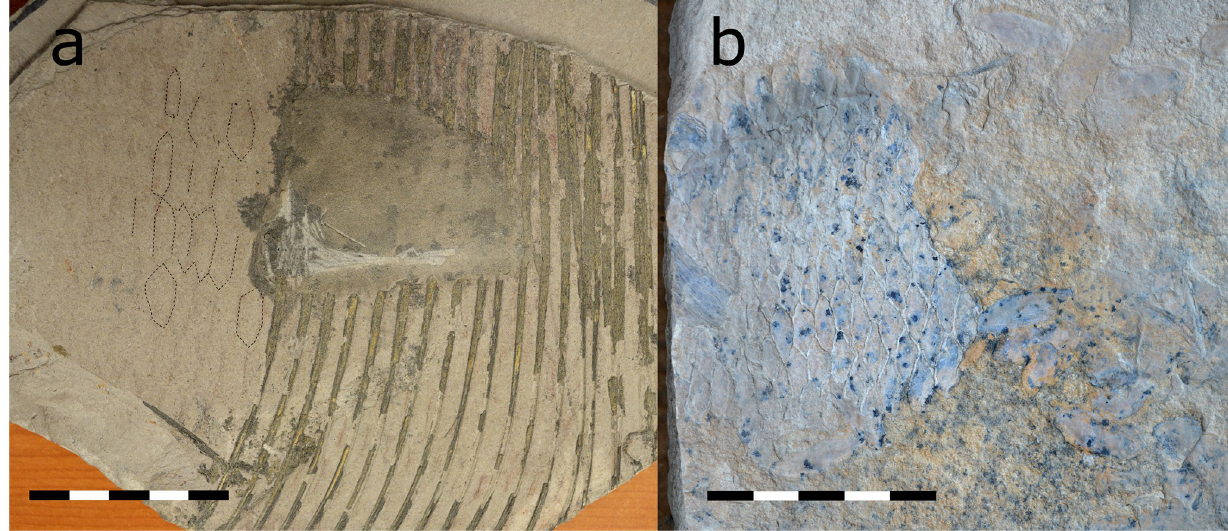
Fig 7. Scales of T . formosa from Vallecillo (CPC-2824) (A) in comparison to Dixonanogmius sp. from San Carlos (CPC-2836) (B). All scales 50 mm.